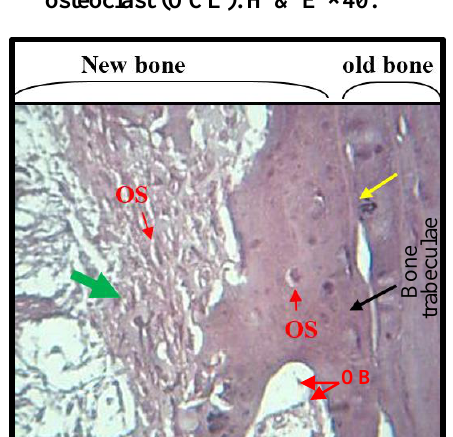
Figure 3: Microscopic view of uncoated implant after 2 weeks. Osteoblasts (OB), pre-osteocytes (POS), osteocytes (OS) & osteoclast (OCL). H & E × 40.